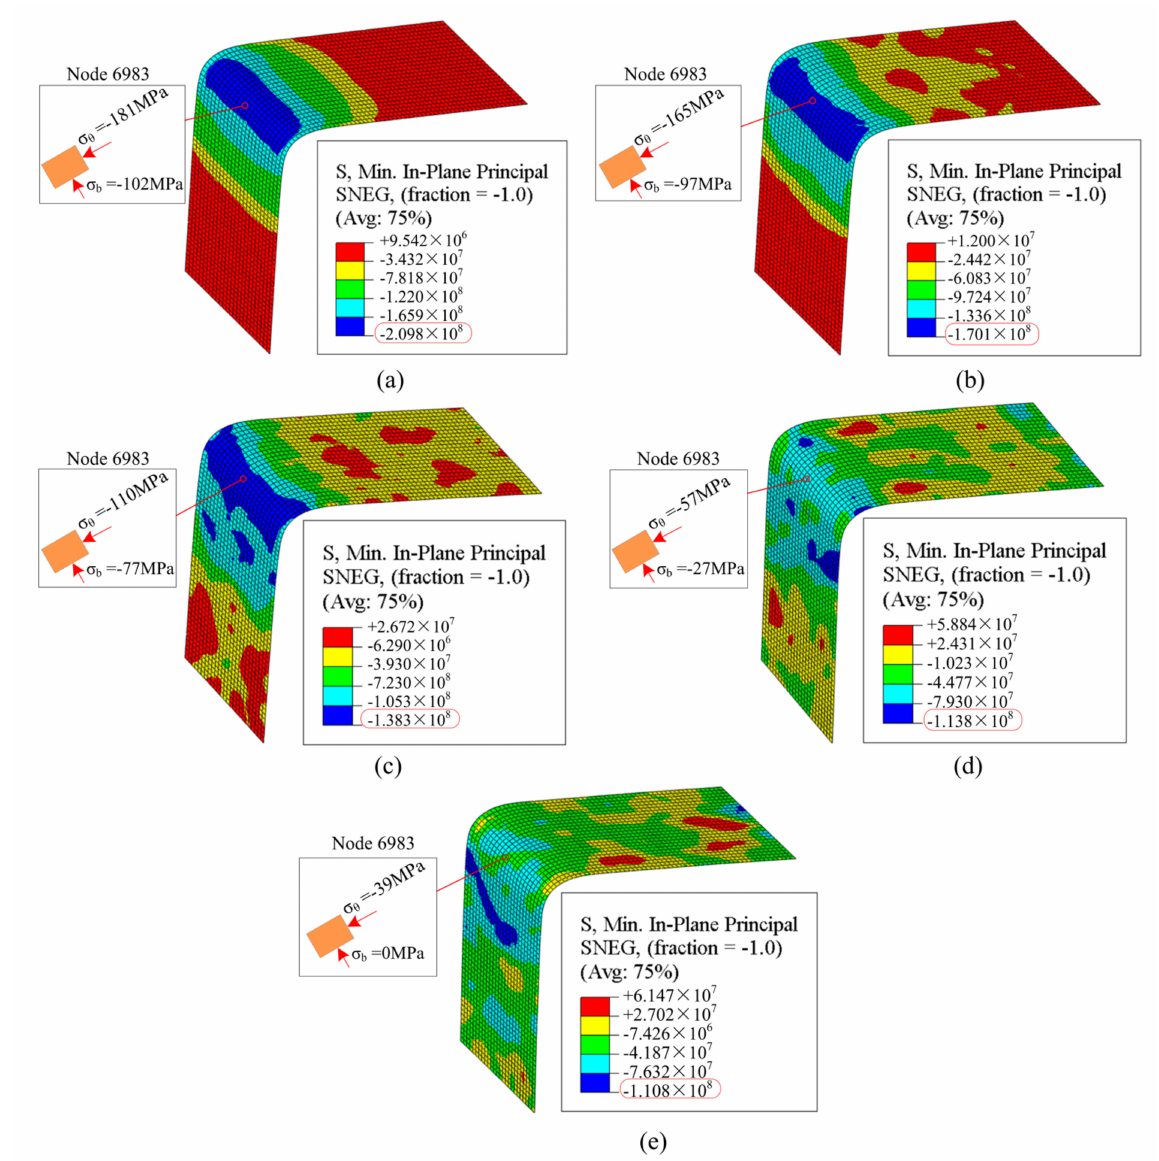
Figure 16. Stress distribution on the inner surface under ( a ) quasi-static stamping or a discharge voltage of ( b ) 5 kV, ( c ) 6 kV, ( d ) 7 kV, and ( e ) 7.5